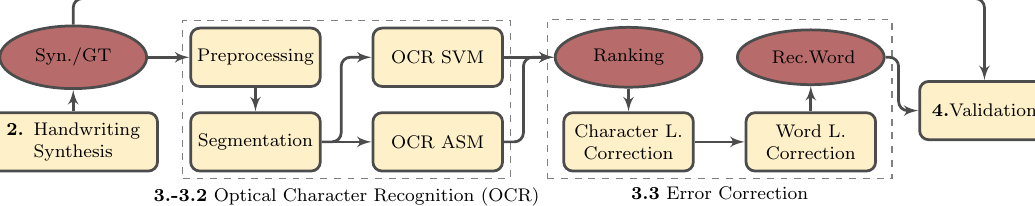
Figure 1. Overview of the proposed